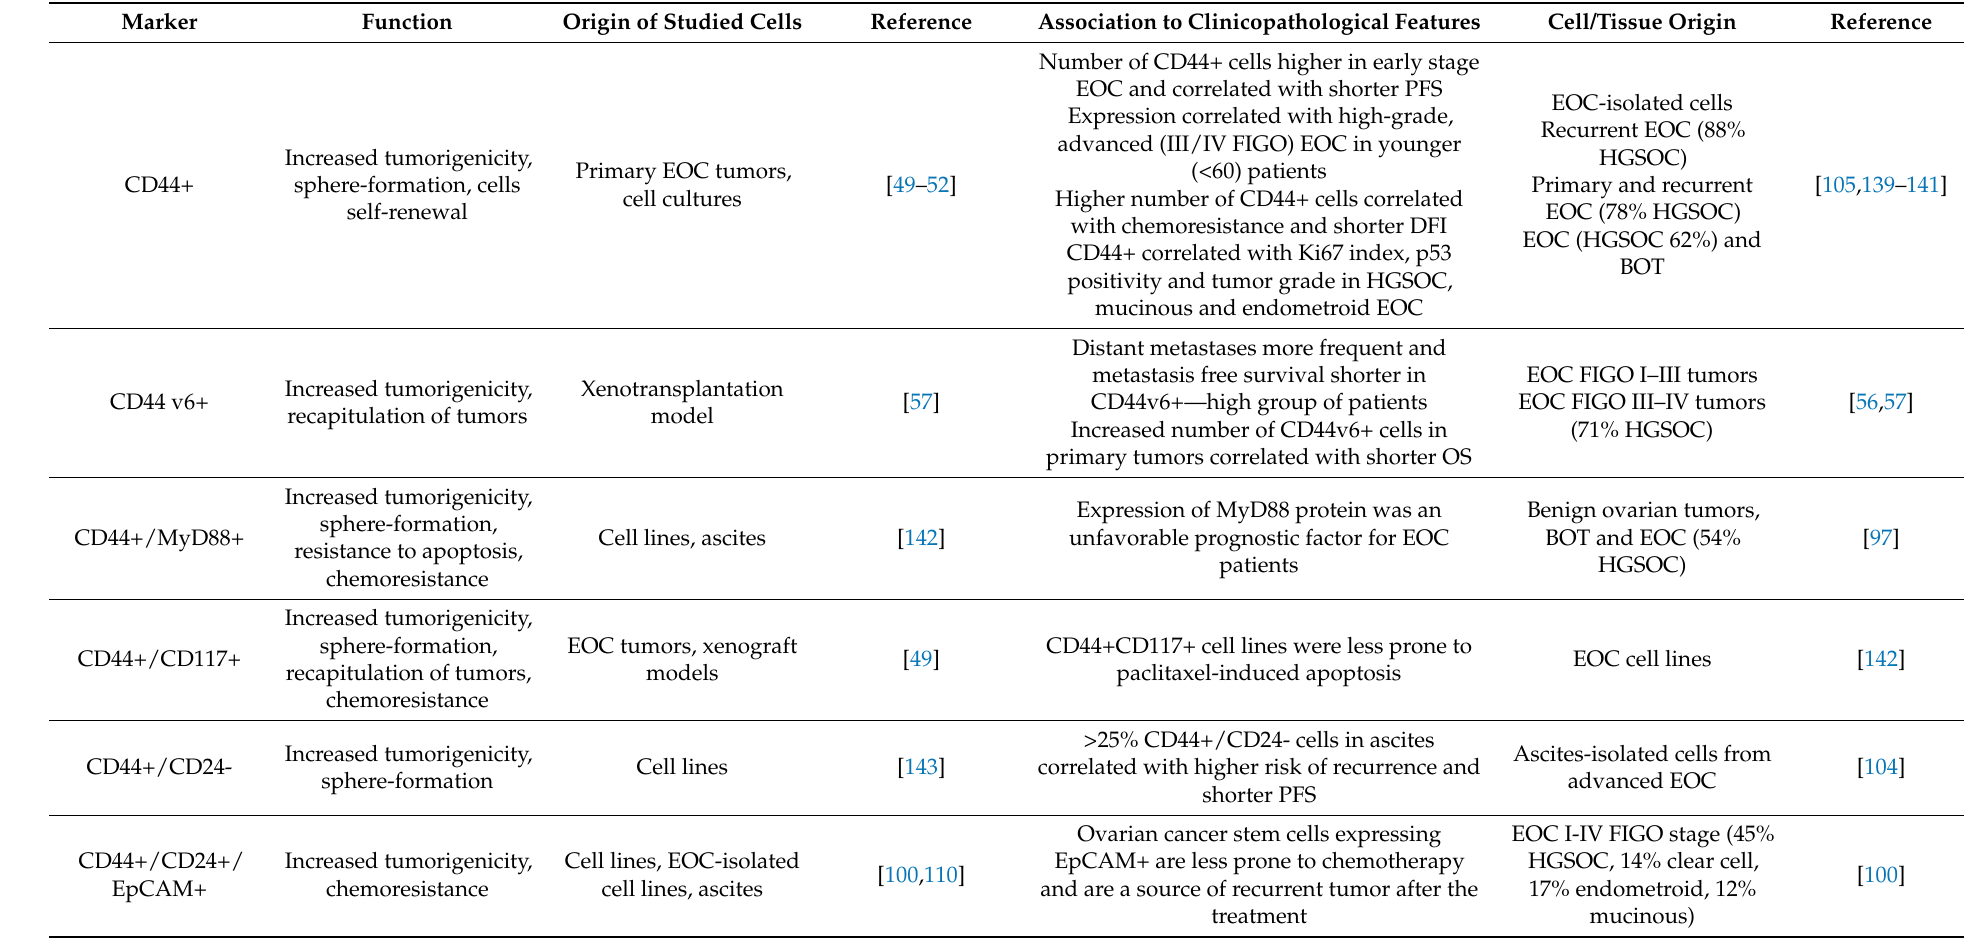
Table 1. Markers of OCSCs—function, correlation to clinicopathological features and their cell/tissue